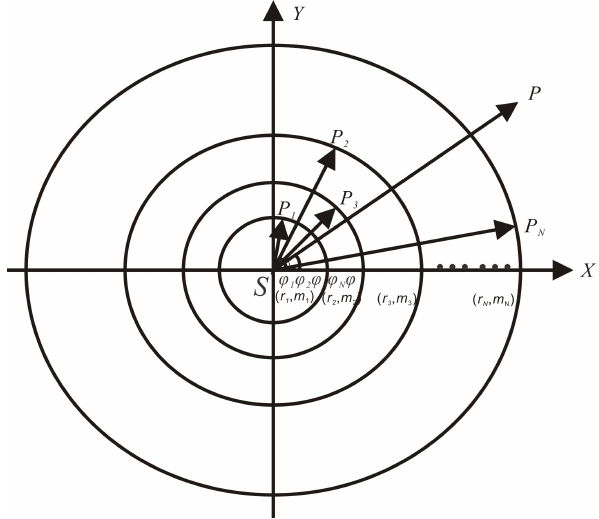
Figure 1. Sketch map of planetary rendezvous.